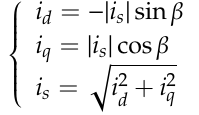
Figure 2. Optimization process diagram of model predictive control (MPC).